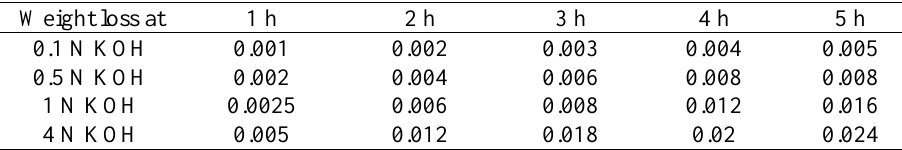
Table 7. Weight loss of Cu in HNO